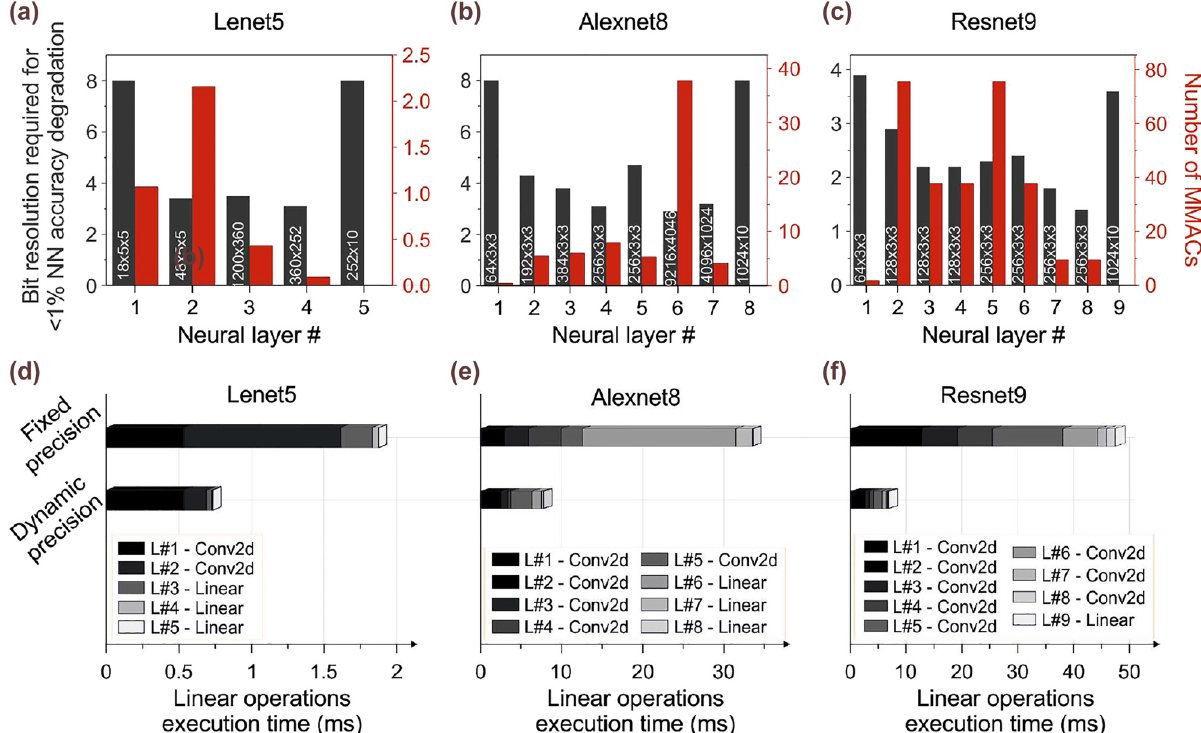
Figure 3: Bit resolution required for < 1% NN accuracy degradation (grey bars) and number of MMACs (red bars) per layer of (a) the Lenet5, (b) the Alexnet8 and (c) the Resnet9 NNs. Linear operations execution time in ms for fixed and dynamic bit precision inference at (d) the Lenet5, (e) the Alexnet8, and (f) the Resnet9 NNs.